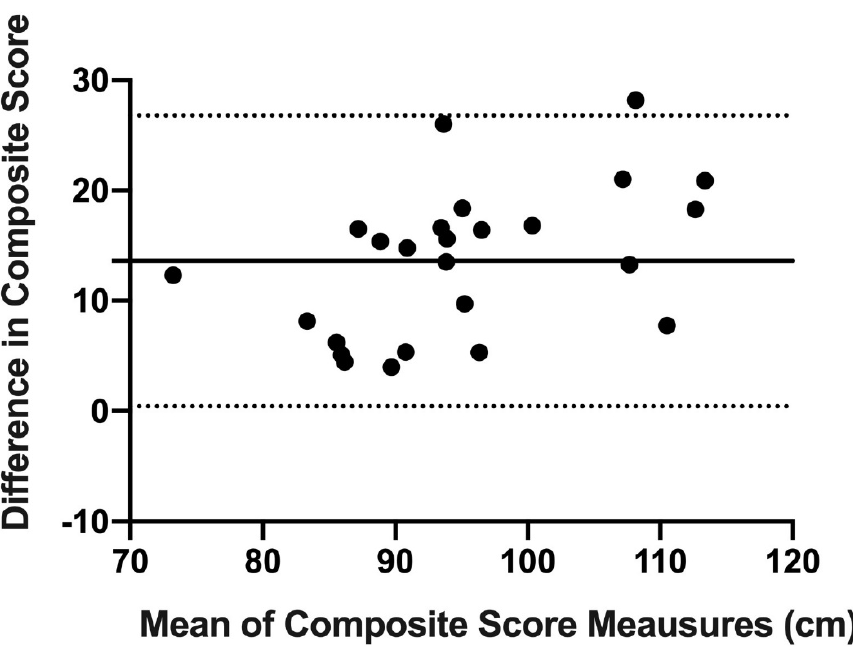
Figure 8. Bland–Altman left medial.